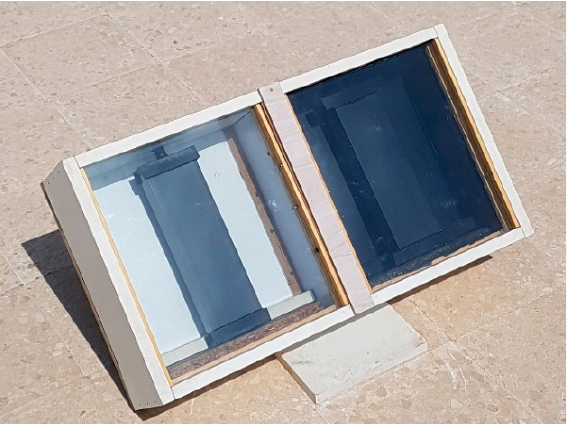
Figure 11. The constructed wooden box with two rooms painted in white and black, with two black-painted Al water containers fixed inside.